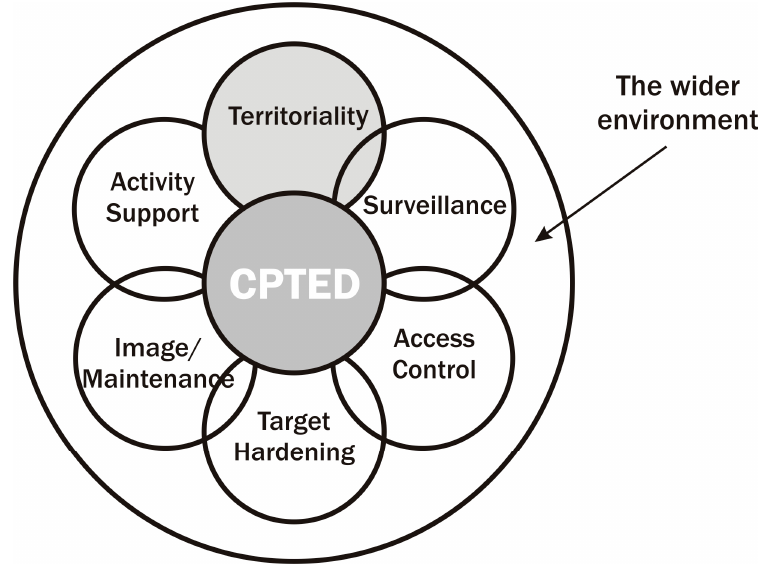
Figure 3. A Revised CPTED Model (Cozens et al. 2005).